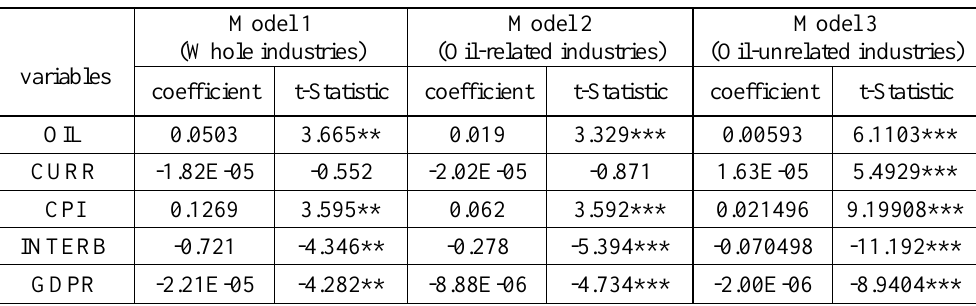
Table 5. PMG long-run